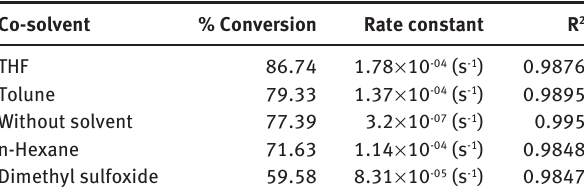
Table 7 Kinetic analysis for the effect of co-solvent addition. Co-solvent % Conversion Rate constant R 2